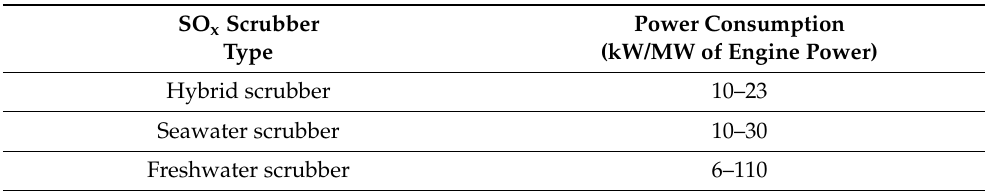
Table 7. Power consumption of three types of SO x scrubbers. (Table was genuinely generated using data from ref.